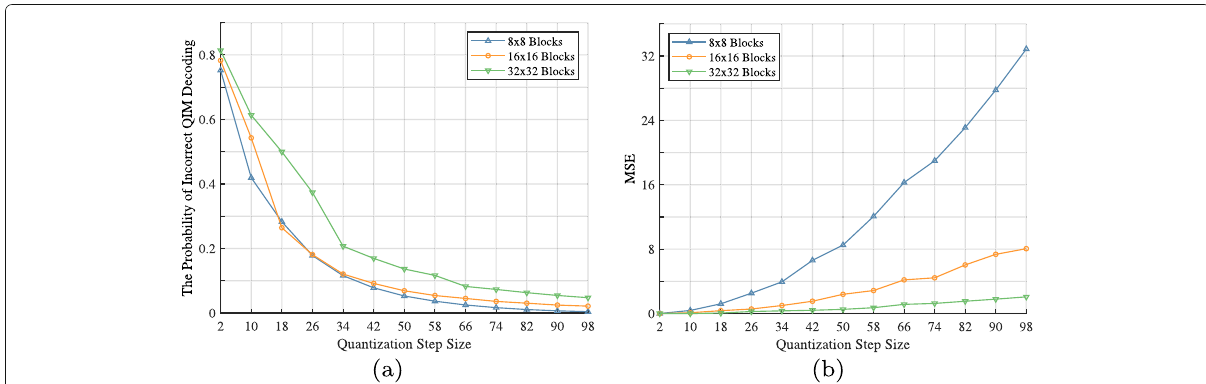
Fig. 10 a , b The relationship of quantization step size, probability of incorrect QIM decoding, and MSE of the cover-stego pairs, under the block size of 8 × 8, 16 × 16, or 32 × 32. The robustness is negatively correlated with the probability of incorrect QIM decoding. The MSE represents the difference between cover videos and stego videos